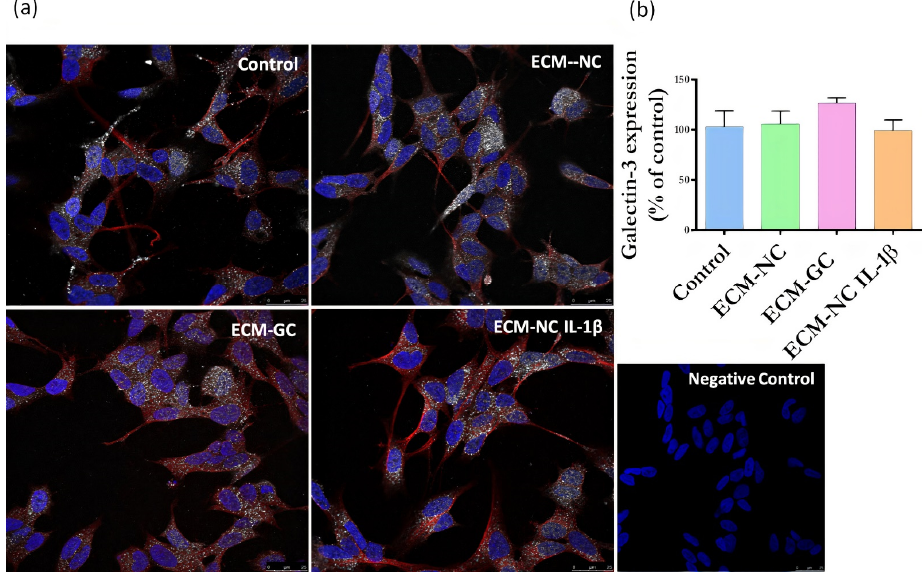
Figure 7. ( a ) Representative images of immunofluorescence of Galectin-3 expression. Neuronal class β -III tubulin (red) 1:500; Hoechst-33342 was used to stain nuclei (blue) 1:3000; Galectin-3 receptor (green) 1:200 in control cells (differentiated/ without ECM) and cells treated with ECM-NC, ECM-GC, ECM-NC IL-1 β . Negative control of immunostaining. Magnification 40×. Scale bar: 25 µm. ( b ) Relative quantification of immunostaining for Galectin-3 representing the ratio between the experimental and the control group. The data were analyzed by t -test. The data represent three independent and similar assays. Data were analyzed by one-way ANOVA with post hoc testing by Dunnett p > 0.05).